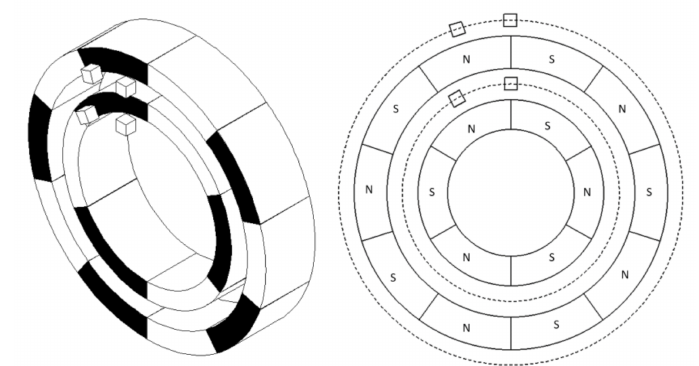
Figure 1. Schematic of the magnetic encoder’s signal generation